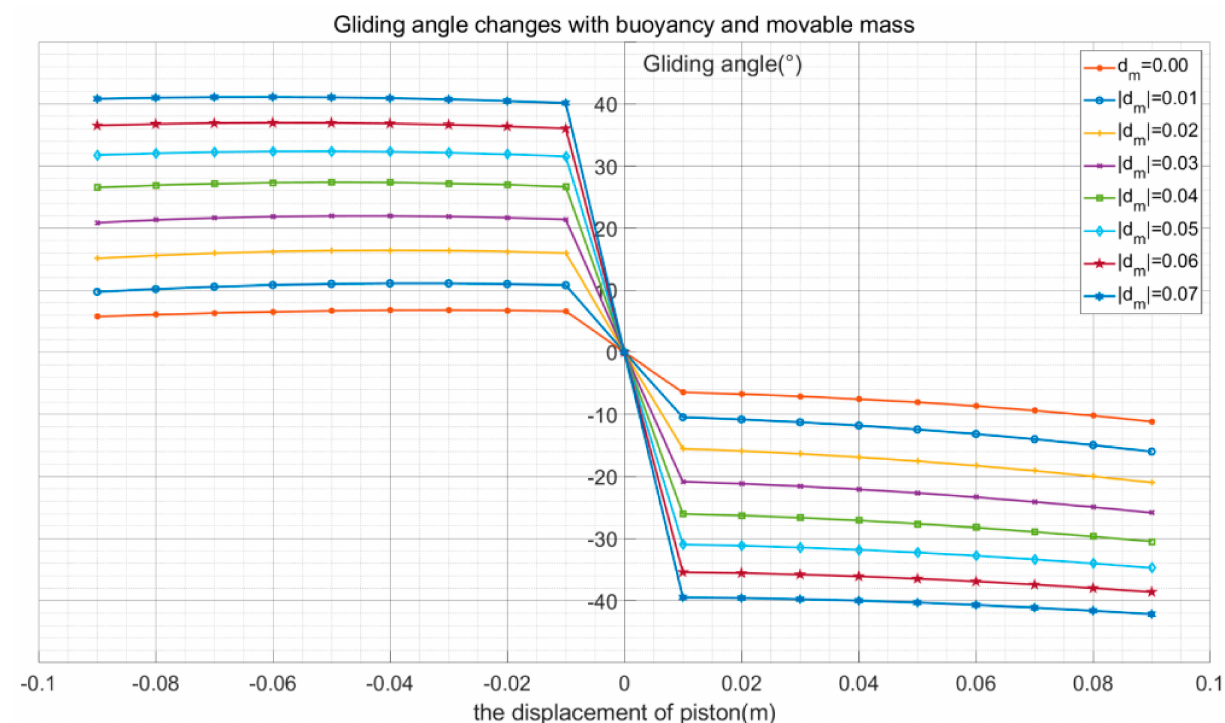
Figure 13. Change in gliding angle with buoyancy and movable mass.